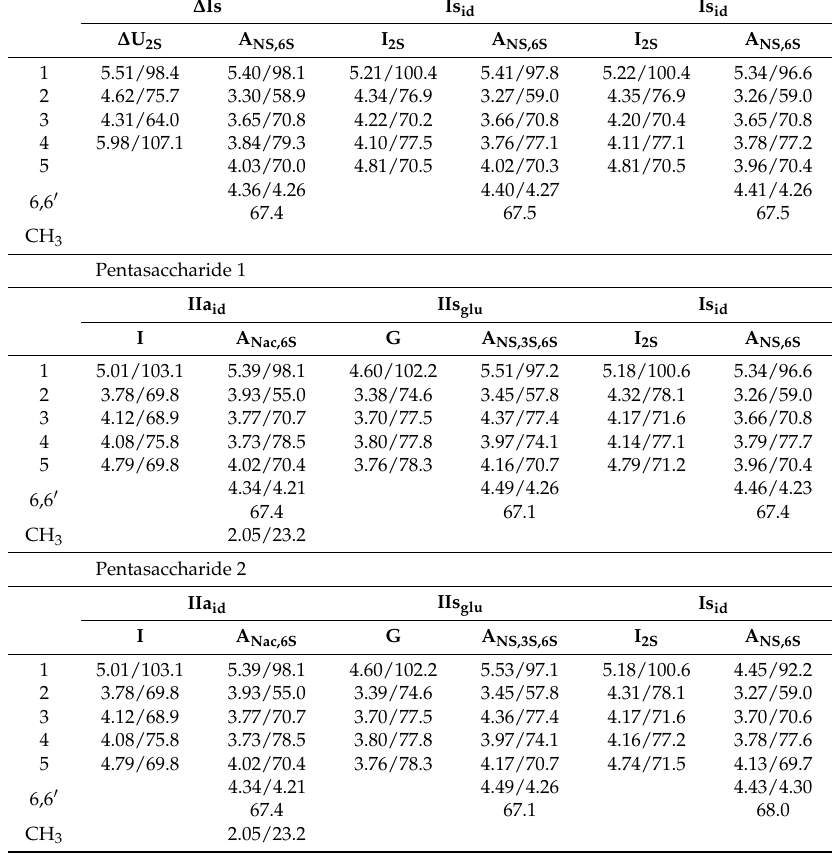
octadecasaccharide 6